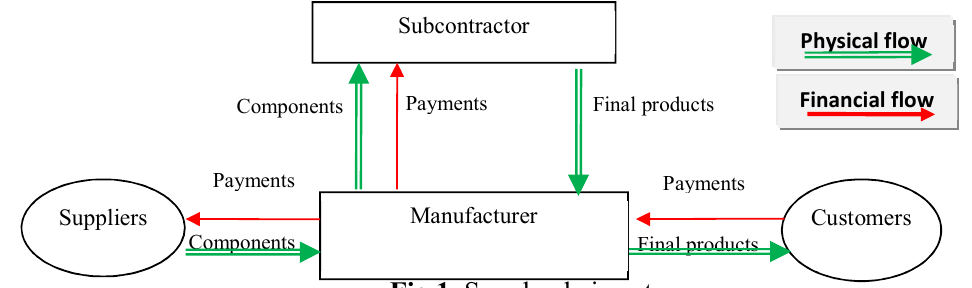
Fig.1. Supply chain